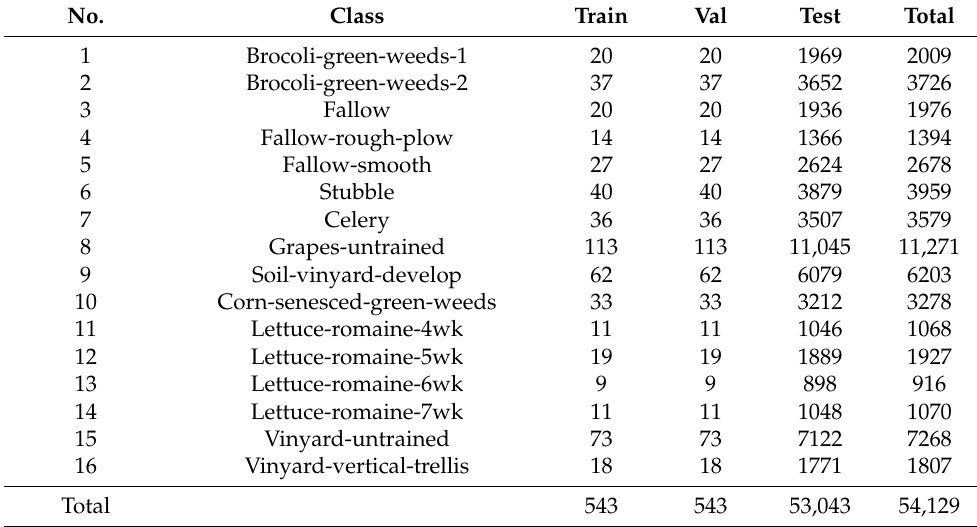
Table 7. Land-cover classes and corresponding numbers of samples in the SA